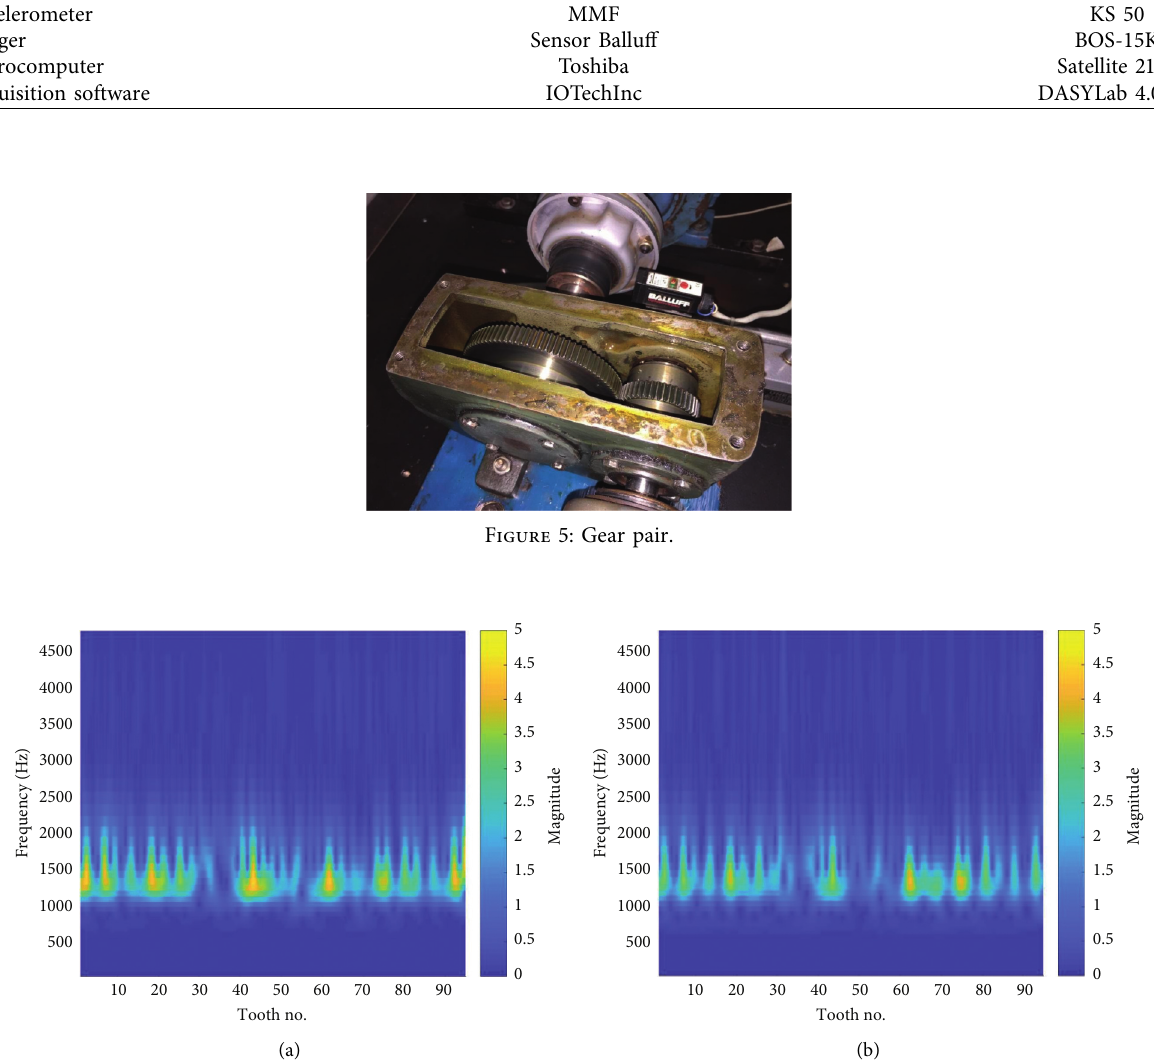
Figure 6: Wavelet analysis: (a) 1 hour and (b) 8 hours of